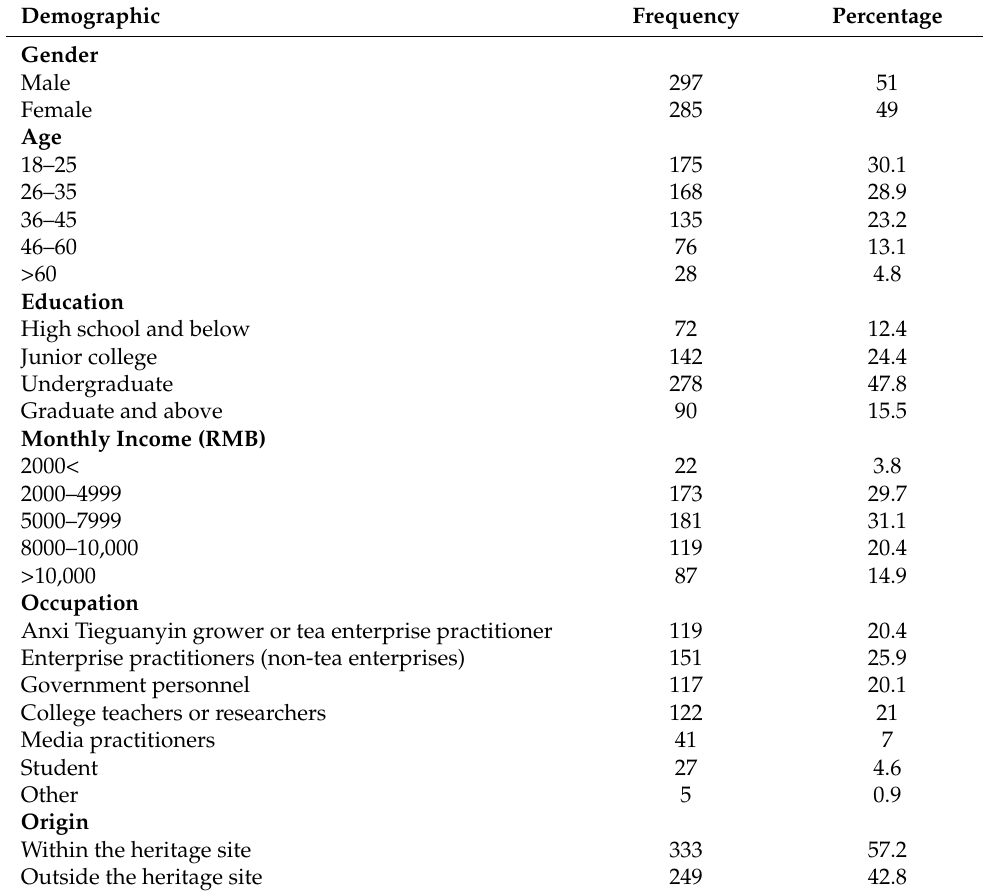
Table 2. Demographic profile of the